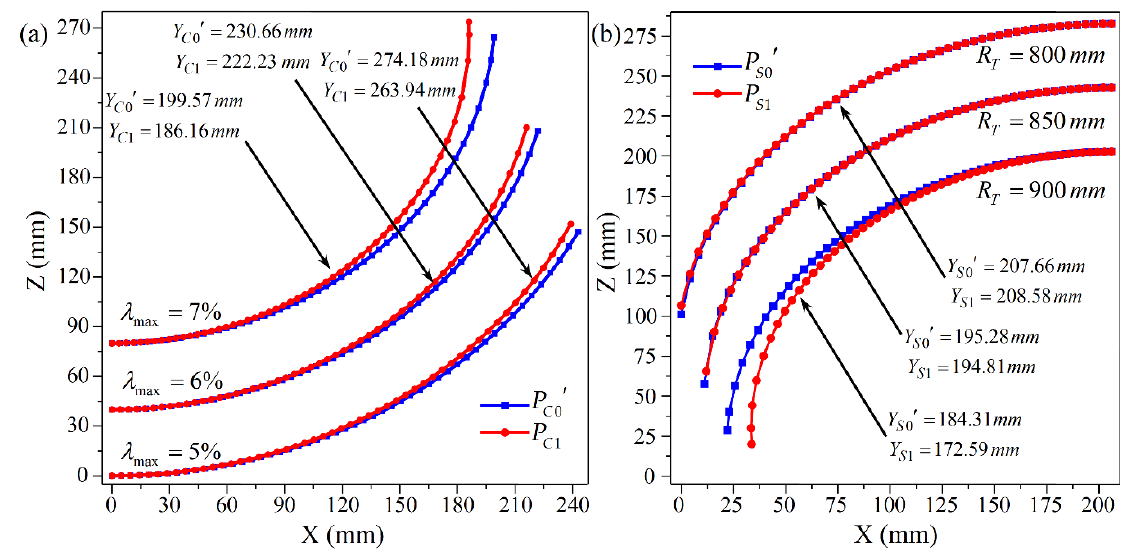
Figure 17. Comparison of the profiles of the longitudinal centerline for 08 Al sheets: ( a ) Positive Gaussian curvature surface;